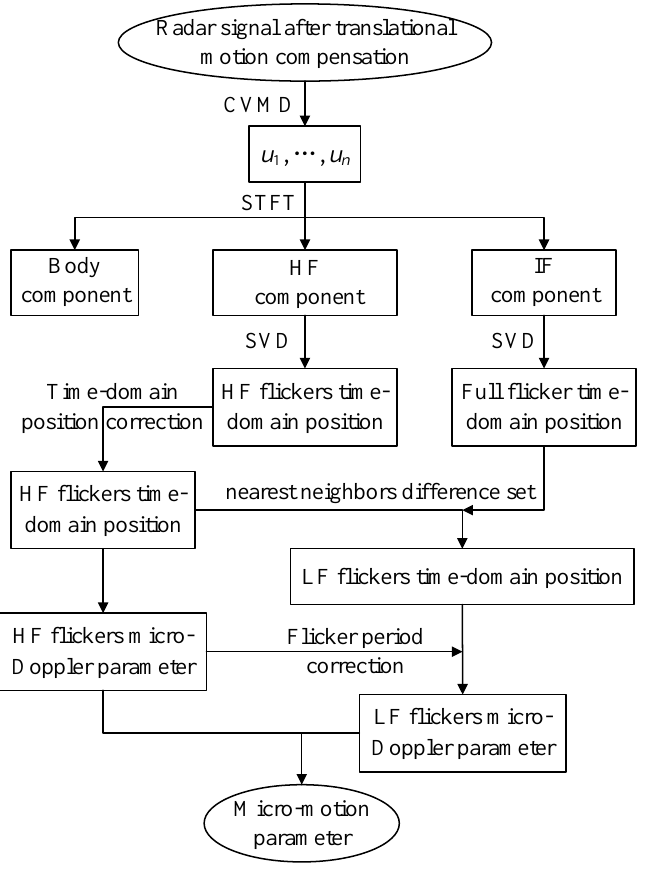
Figure 6. Basic process of multi-rotor micro-motion parameter extraction. In which HF means high-frequency, IF means intermediate frequency, and LF means